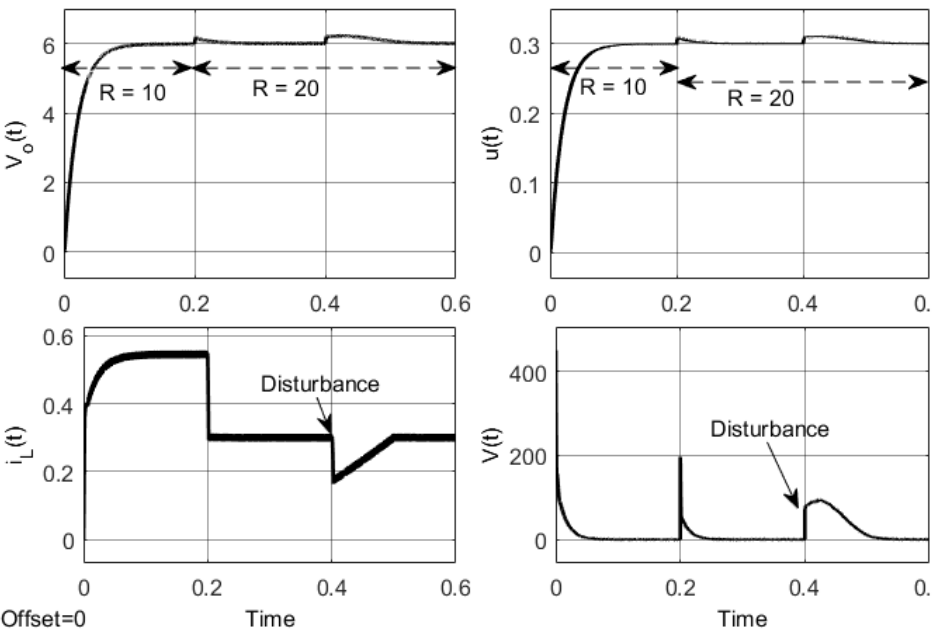
Figure 4. Time trajectories of the output voltage v o ( t ) , inductor current i L ( t ) , control signal u ( t ) , and the Lyapunov function (Load variation + disturbances +